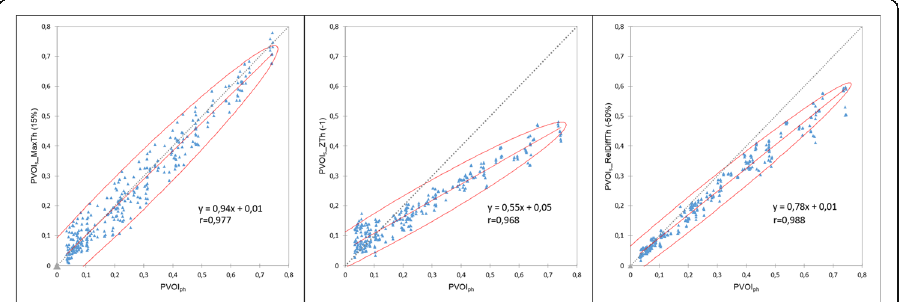
Fig. 6 Pearson's correlation between PVOI ph and PVOI s for the three segmentation methods. Person ’ s coefficient was higher for RelDiff method, but the slope was closer to 1 for MaxTh